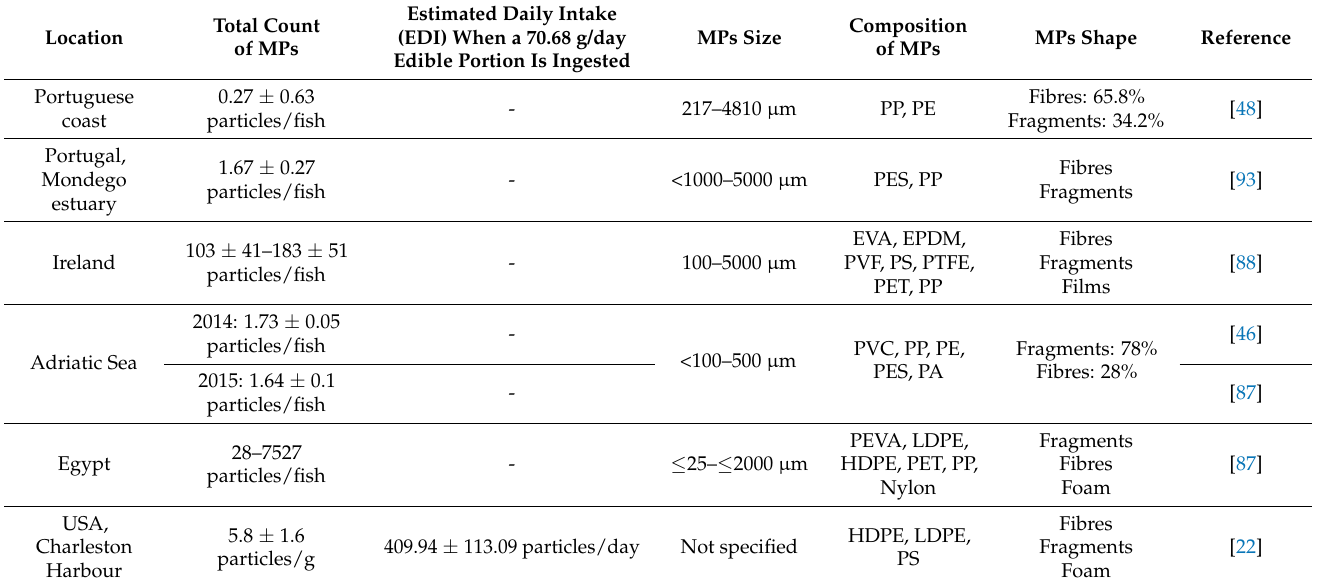
Table 3. MPs contents in fish and estimated daily intake in a 70.68 g fish/day consumption